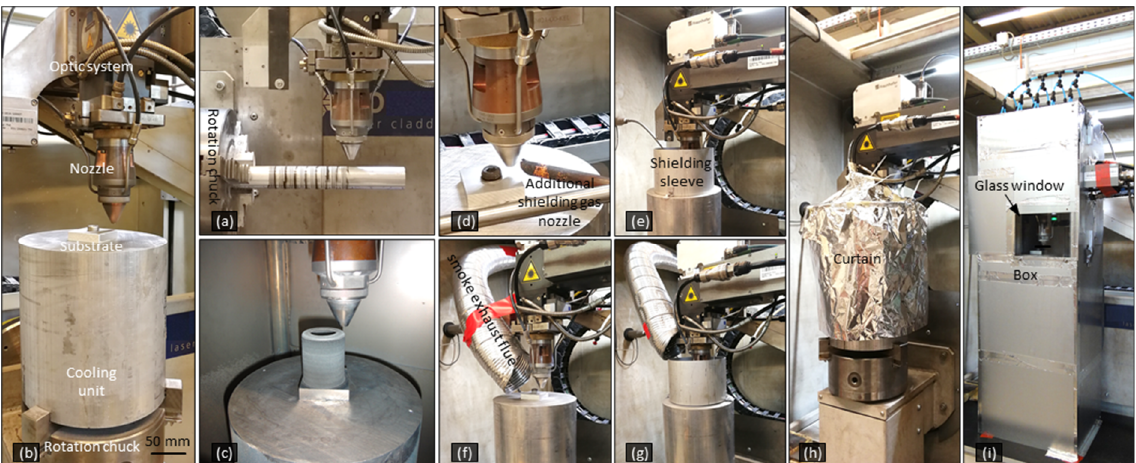
Figure 4. Photos of the basic experimental setup for fabricating ( a ) single tracks and ( b ) 3D-parts “Or”. Most of the 3D-parts like that shown in ( c ) were made with additional shielding concepts: ( d ) an additional shielding gas flow “Ad”, ( e ) a shielding sleeve “Ri”, ( f ) a smoke exhaust flue “Ex”, ( g ) a combination of the sleeve and the flue “RE”, ( h ) an Al curtain “Fo”, and ( i ) a protective box “Bo”. The designators in quotation marks are the short forms used in Table 1. “Bo” has a larger interior space and is thus more heat resistant than “Fo“. The letters in quotation marks are specimen designations (see Table 1). Table 1. Parameter sets of laser power P , travel speed v , nozzle’s own shielding gas flow rate V s , additional shielding gas flow rate V ad . and shielding and exhausting measures for